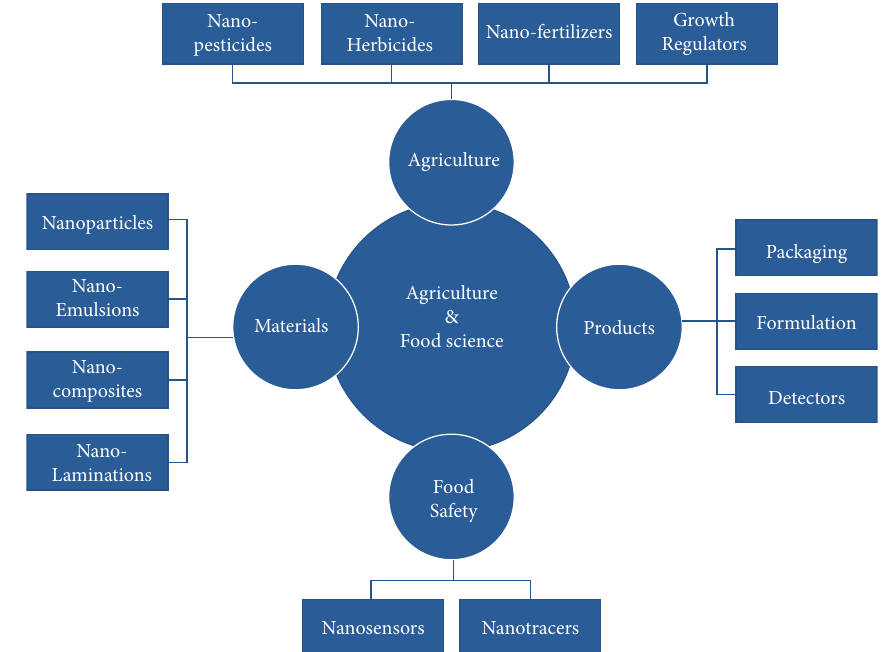
Figure 1: A graphic expression of bids of nanotechnology in agro-food